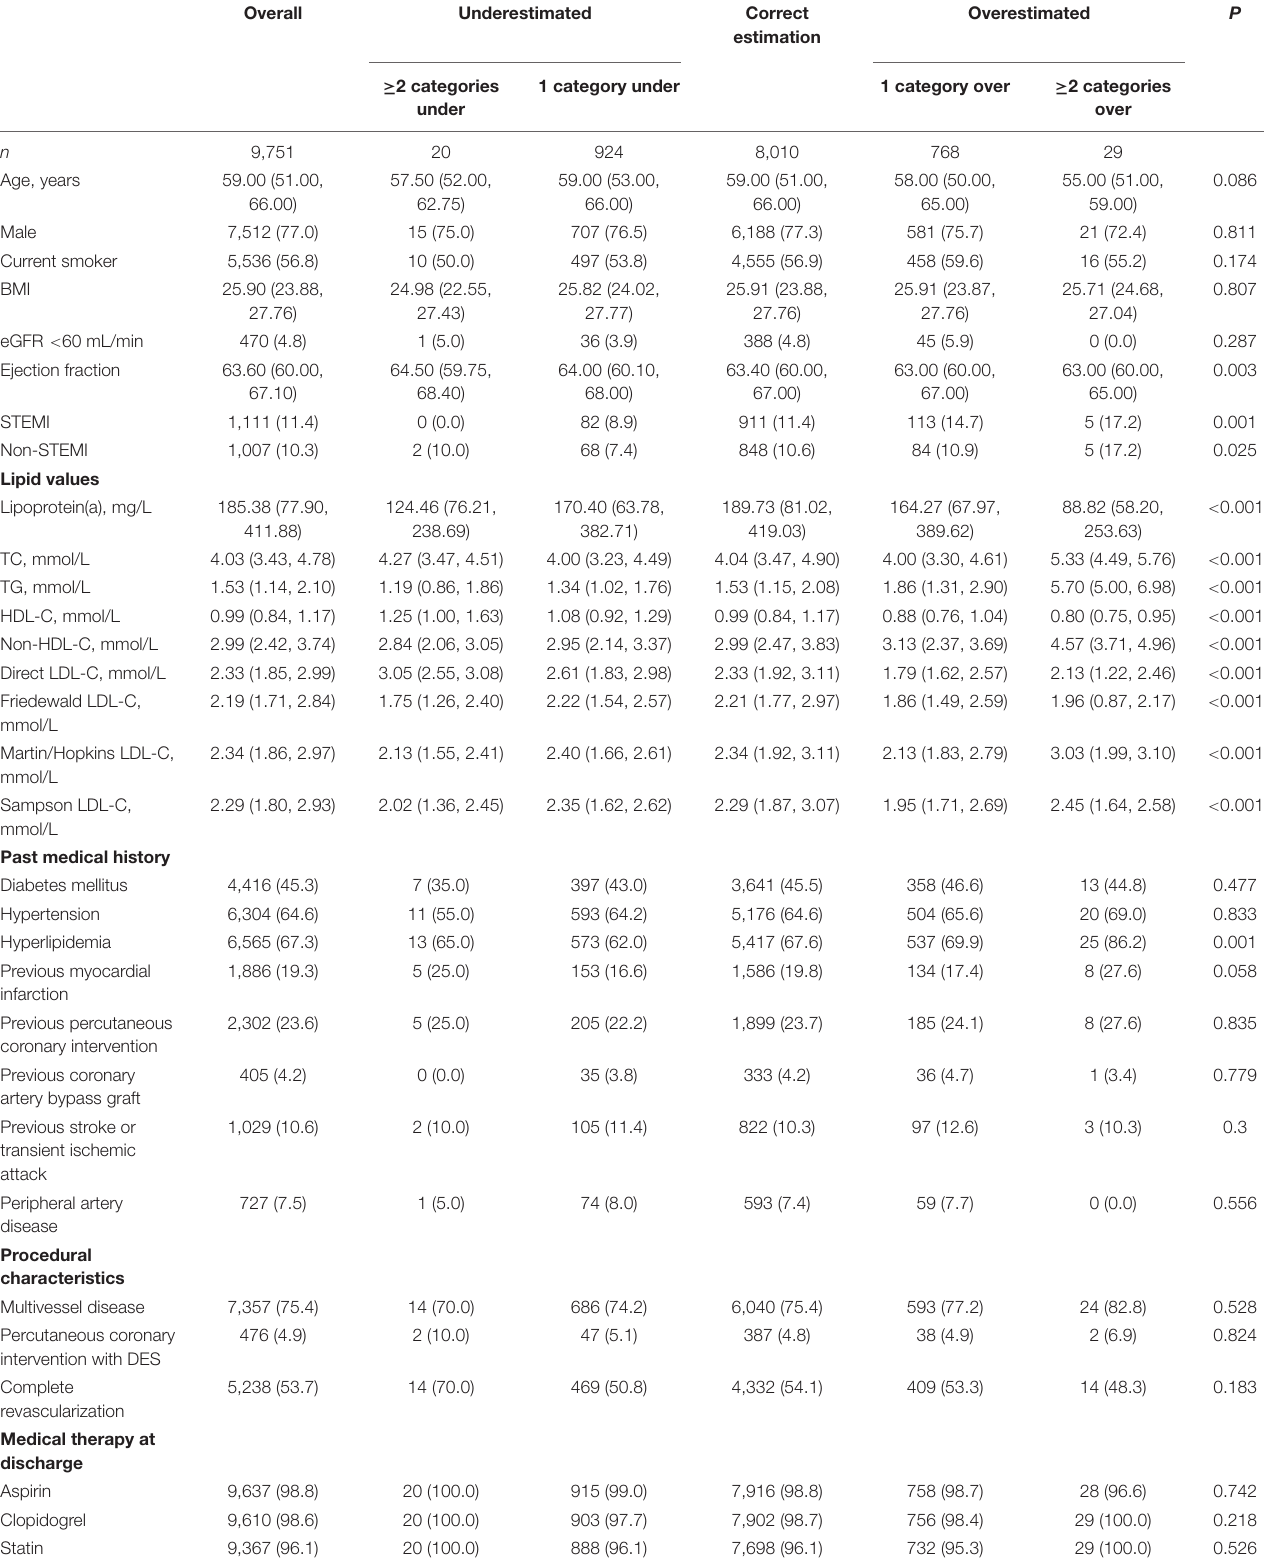
TABLE 1 | Baseline features and adverse outcomes according to concordance between the Martin equation and direct method. Overall Underestimated Correct estimation